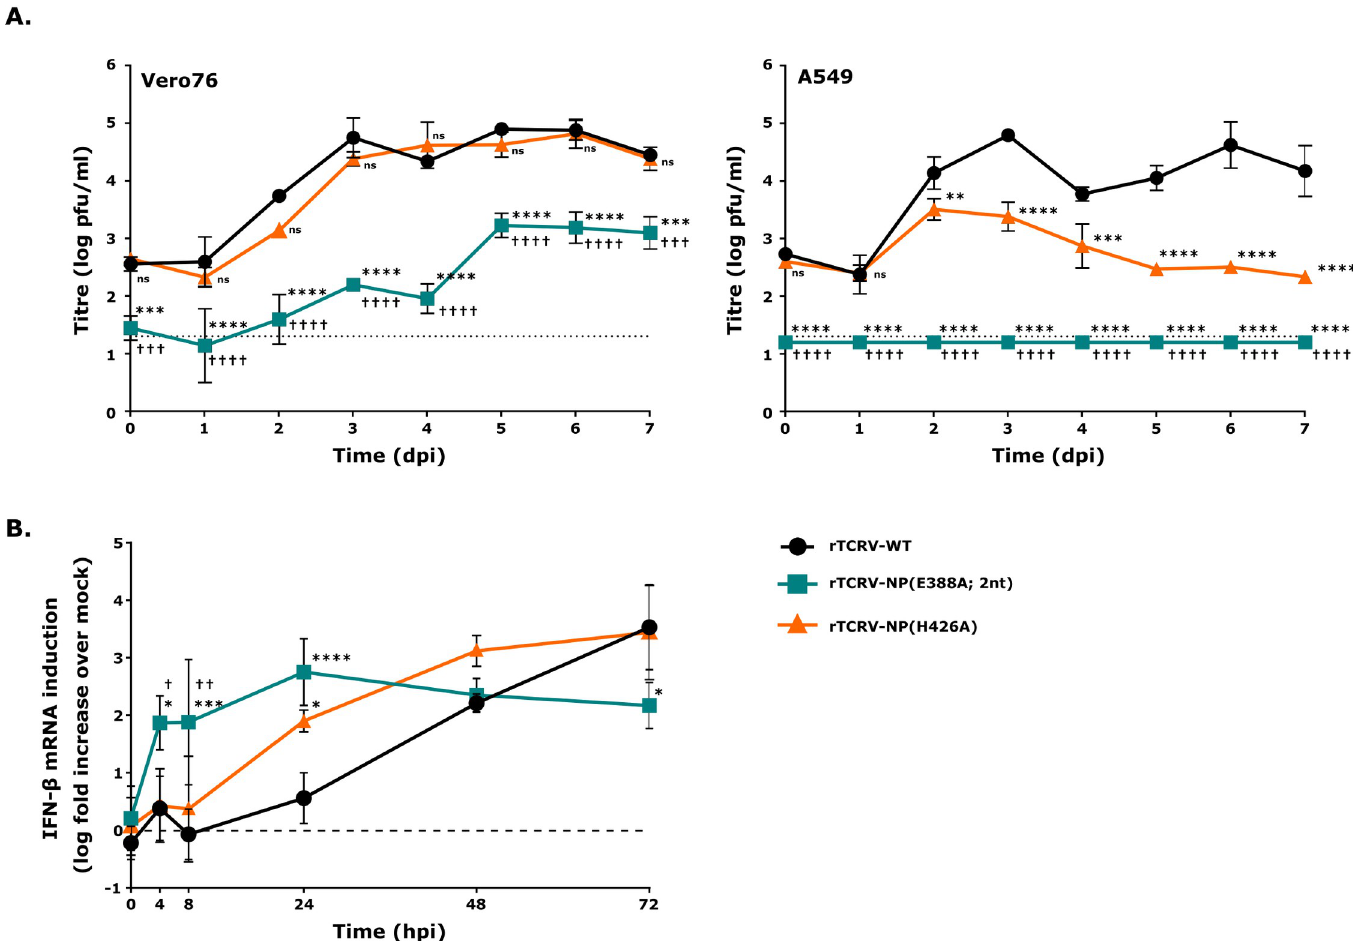
Fig 6. Characterization of recombinant TCRV encoding exonuclease mutants of NP. (A) Comparison of growth kinetics. Vero76 and A549 cells were infected at an MOI of 0.05 with either rTCRV encoding NP wild-type (rTCRV-WT) or the indicated mutants (i.e. rTCRV-NP(H426A) or rTCRV-NP(E388A; 2nt)) and supernatants were collected from day 0 to 7 for titration by plaque assay. The data are shown as means and standard deviations of 2 independent experiments. The limit of detection of the assay is indicated as a dotted line. (B) Interferon- β mRNA induction. A549 cells were infected as described in (A) and RT-qPCR was performed with GAPDH and IFN- β primers at the indicated time points. IFN- β mRNA levels were calculated as fold induction over mock (indicated as a dashed line) using the ΔΔ Ct method (i.e. standardized to GAPDH and mock). Data are shown as the means and standard deviations of three independent replicates. Statistical analysis was performed using two- way ANOVA with Dunnett’s post-hoc test for differences compared to rTCRV-WT, indicated with stars ( � p � 0.05, ��� p � 0.001, ���� p � 0.0001, all other pairings were not significant), or using Tukey’s post-hoc test for differences between rTCRV- NP(E388A; 2nt) and rTCRV-NP(H426A), indicated with daggers († p � 0.05, †† p � 0.01, all other pairings were not